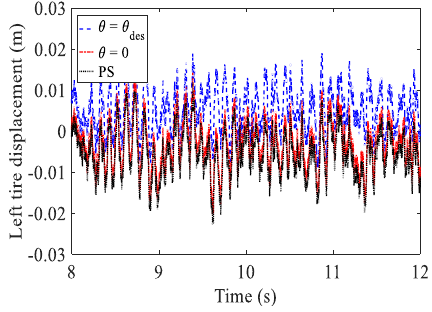
Figure 13. Left tire displacement.